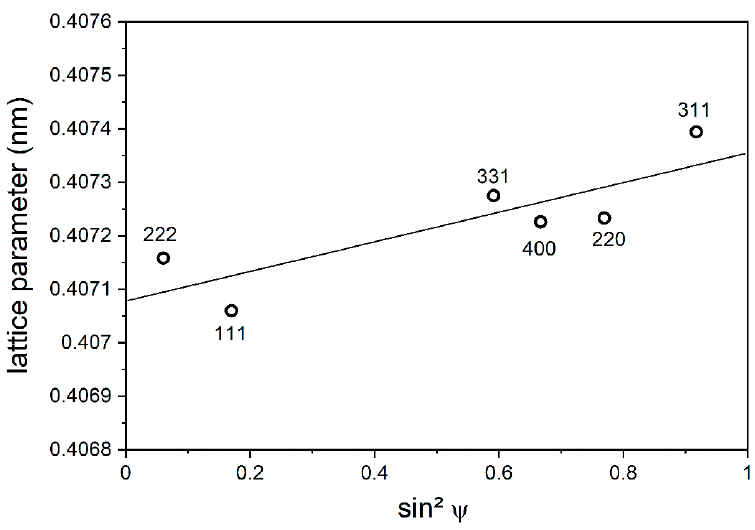
Figure 3. Dependence of the lattice constant on sin 2 ψ for the Ti 1 − x Al x N coating on WC-Co sub- strate.